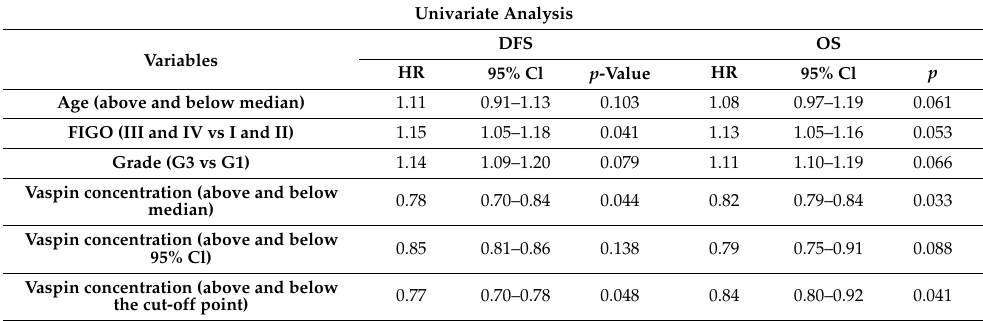
Table 9. Evaluation of patient survival using univariate and multivariate Cox regression: DFS, disease-free survival; OS (overall survival); Cl, confidence interval; p , probability